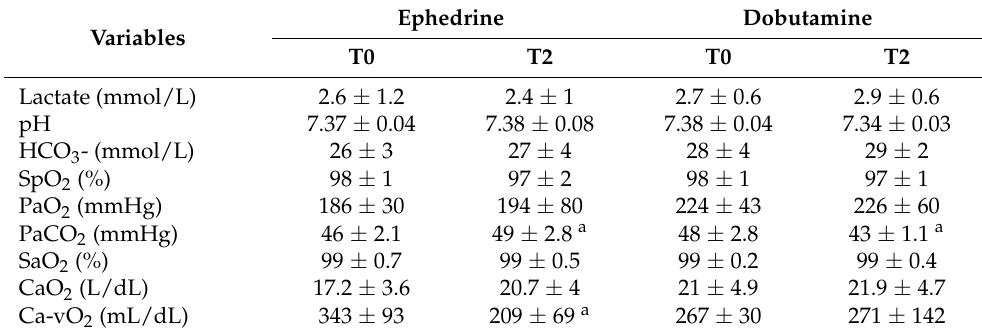
HCO 3 -: bicarbonate ion, SpO 2 : peripheral oxygen saturation, PaO 2 : arterial oxygen partial pressure, PaCO 2 : arterial carbon dioxide partial pressure, SaO 2 : arterial oxygen saturation, CaO 2 : arterial oxygen content, Ca-vO 2 : arteriovenous oxygen difference. Superscript letters indicate a significant difference ( p < 0.05) from the basal moment ( a